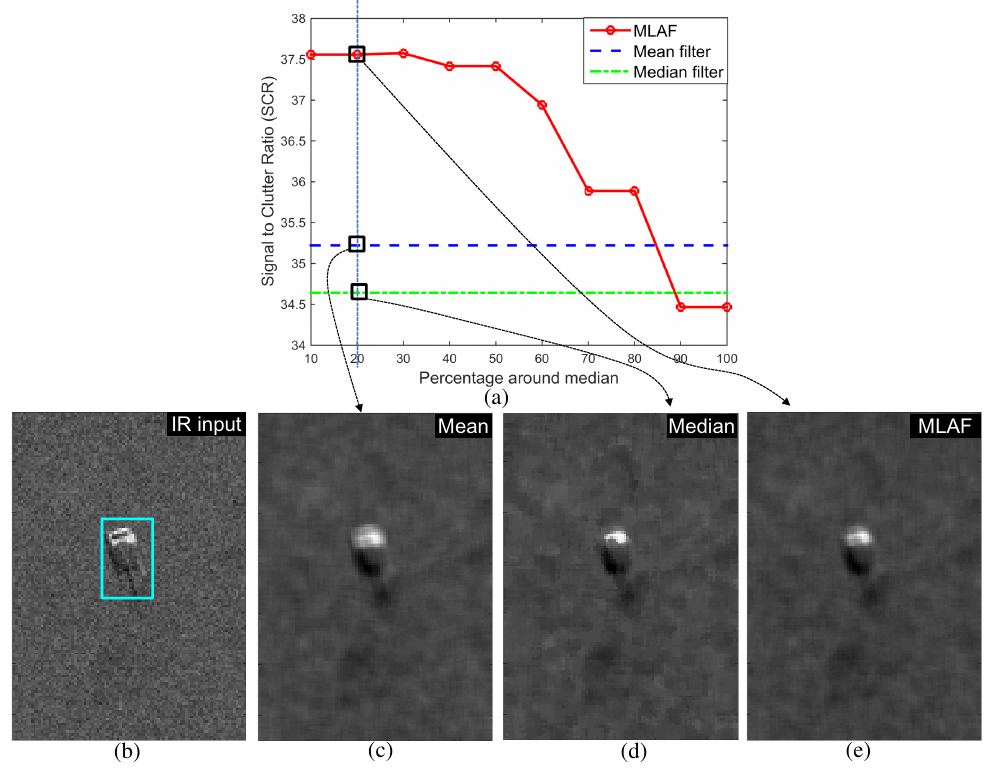
Figure 21. IR noise removal comparison: ( a ) signal-to-clutter ratio by varying the percentage around the median value in MLAF; ( b ) IR test image; ( c ) mean filter result (5 × 5); ( d ) median filter result; ( e ) proposed MLAF result at 20% around the